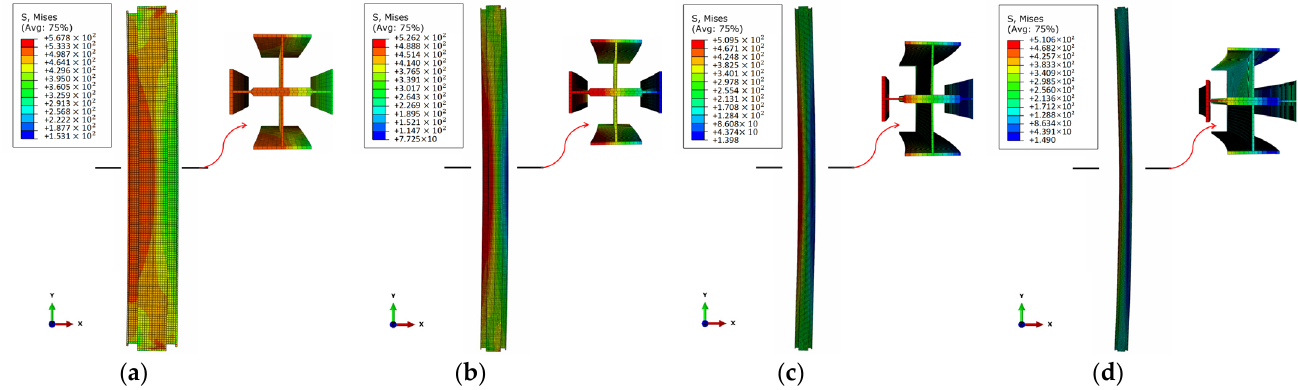
( d ) Figure 10. The FCHC-2-7 series illustrates the typical failure mode of the flexural buckling: ( a ) FCHC-2-7-3; ( b ) FCHC-2- 7-6; ( c ) FCHC-2-7-9; ( d ) FCHC-2-7-12. From Equation (9), the warping constant C w = 0. Therefore, it is easy for the global torsional buckling for an ideal Euler FCHC to occur, especially for a short column or an intermediate column. However, under an inevitable initial imperfection, the global buck- ling mode of FCHCs is flexural buckling and not torsional buckling. As the columns of the steel moment-resisting frames are always the compression-bending members (beam- columns), global torsional buckling never happens. The stability analysis of the axial compression column is the basis of the overall sta- bility design of the compression-bending column, especially the global flexural stability